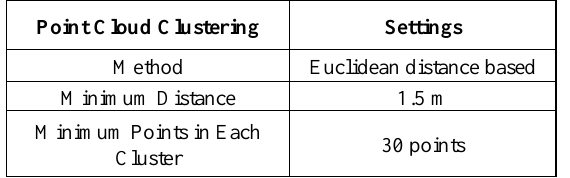
Table 1 . Point cloud segmentation settings.